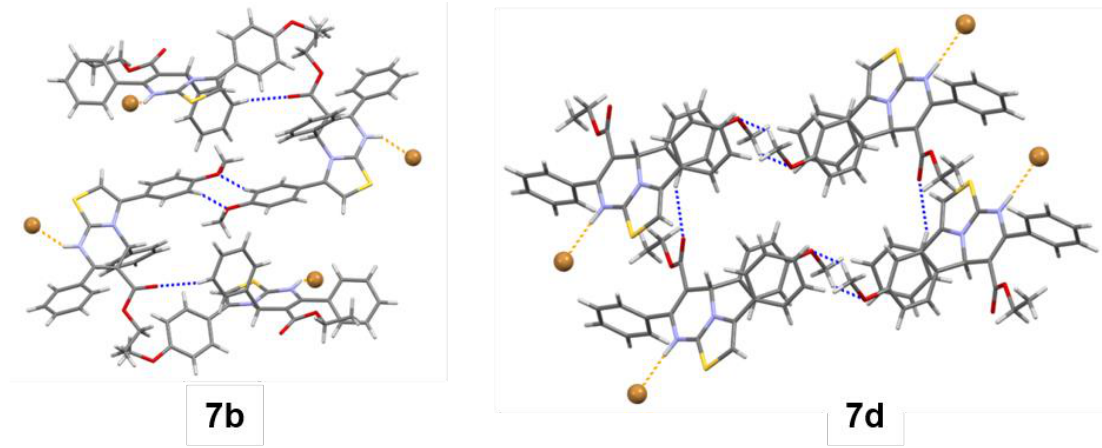
Figure 5. Main supramolecular interactions in compounds 7b and 7d (classical hydrogen bonds are represented in orange, weak hydrogen bonds in blue).